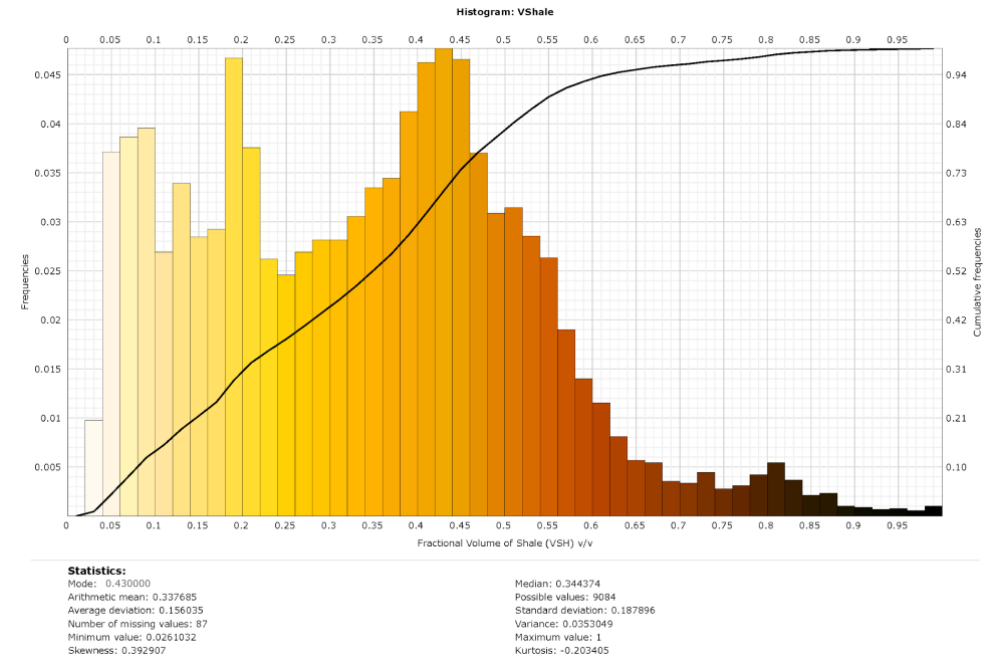
Figure 3. Histogram of VSH values (v/v) over the study well ( x -axis), frequencies (left y -axis) and cumulative frequencies (right y -axis and black curve) A number of dominant lithologies are apparent, including clean carbonates (VSH less than 0.1), dirty limestones (VSH from 0.15 to 0.25), shales (VSH above 0.25) and clay-rich shales (VSH above 0.7). The shales with low VSH indicate high quartz content in the fine-grained fraction.